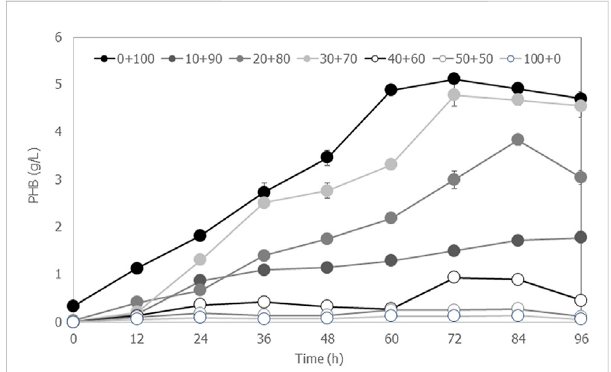
FIGURE 5 TimecoursesofPHBproductionby Cupriavidusnecator strainA- 04whenthehydrolysatewasmixedwith mineralsaltmediumatratios of0:100, 10:90,20:80,30:70,40:60,50:50 and100:0(v/v),where the C/N ratio was set at 200. All the data are representative of the results of three independent experiments and are expressed as the mean values ± standard deviations (SD).